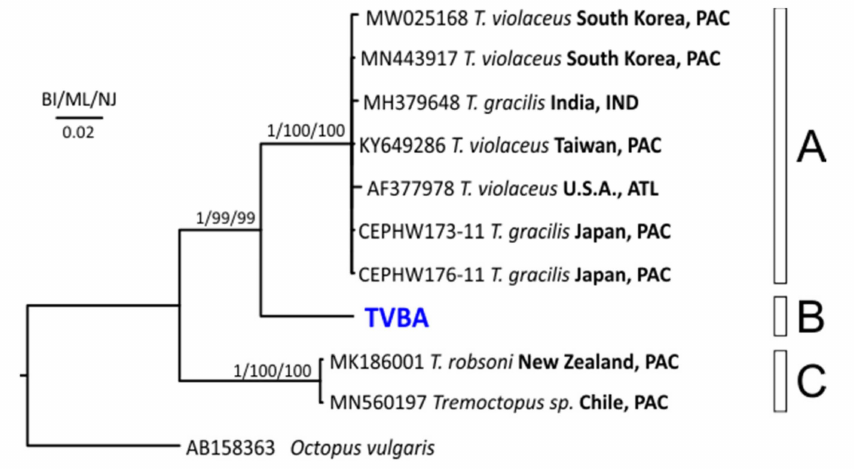
Figure 3. Phylogenetic tree obtained with the cytochrome c oxidase subunit I (COI) sequences. Near the nodes are the support values for the BI, ML, and NJ methods. PAC, Pacific Ocean; IND, Indian Ocean; ATL, Atlantic Ocean. Table S1 contains all details and references of the sequences used. In blue is the Tremoctopus ’ sequence from the Mediterranean Sea. Next to the tips are the GenBank accession numbers, under which the sequences are deposited in the repository, and their geographical origins. The letters near the tree (A, B and C), indicate the